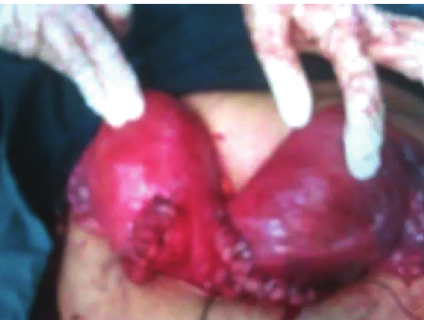
Figure 1: Intraoperative image of the gravid uteri, after delivery of both fetuses by lower uterine caesarean incisions; we started with the right horn and then the left one; the right horn contained a single female fetus; the left horn contained a single male fetus. The uterine incisions were repaired in two layers without any trauma to the bladder or the